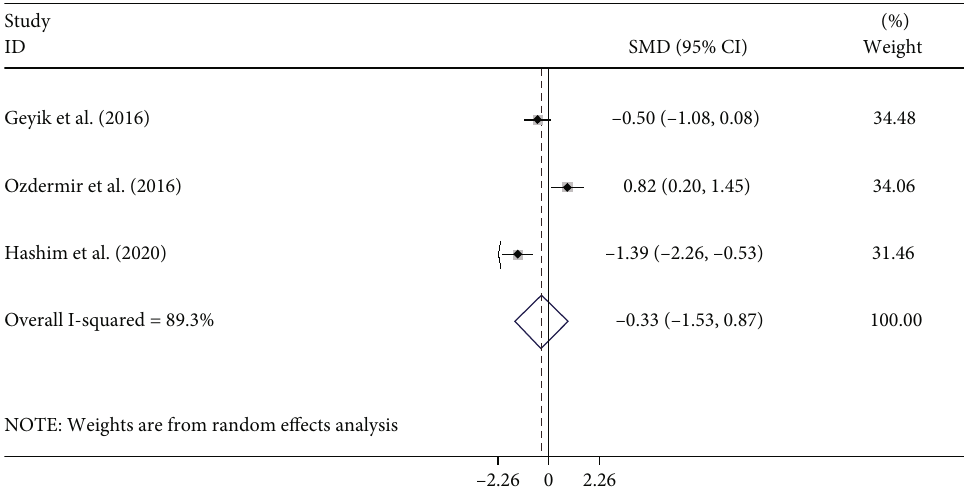
Figure 12: Meta-analysis of di ff erences in NLR levels between patients with AIDP and AMSAN